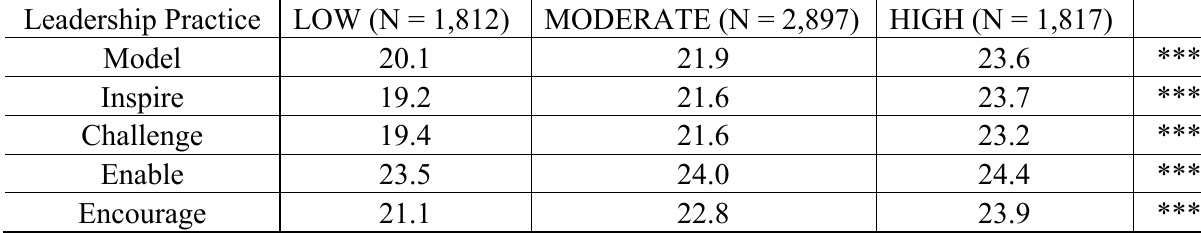
Table 10a. Comparisons by Perceived Leadership Skills (Self).